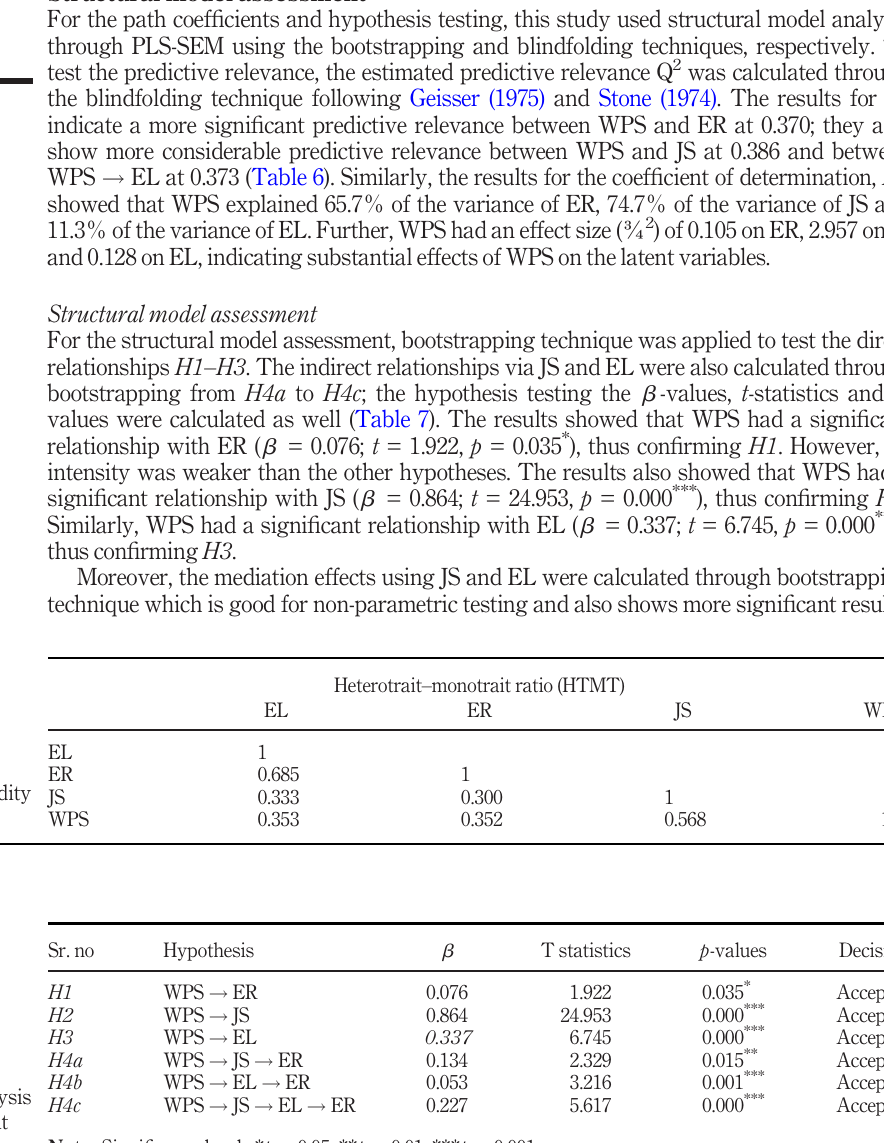
Table 6. Relationship analysis through consistent bootstrapping